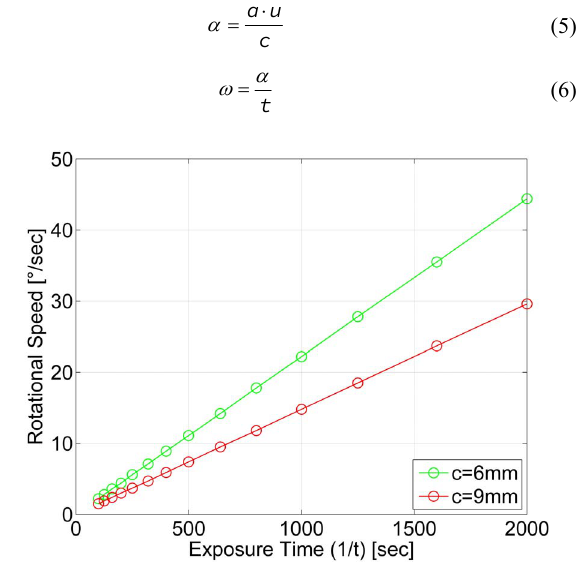
Figure 7: Maximum tolerable rotational speed of UAS For an exposure time of 1/800 sec the allowed rotation speed for c = 9mm will be 11.8°/sec. These rotational speeds are common during flights under low wind conditions (2 - 3